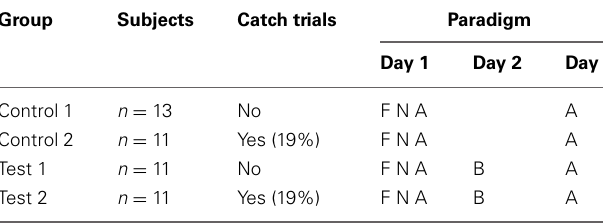
Frontiers in Psychology | Movement Science and Sport